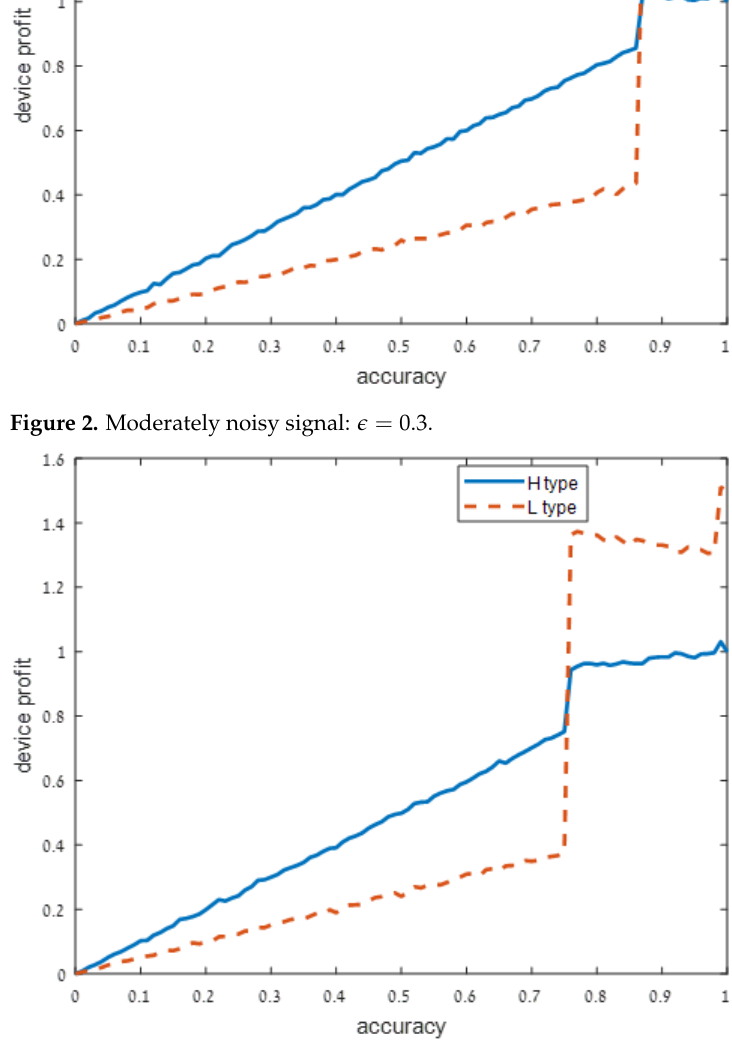
Figure 3. Moderately noisy signal: (cid:101) =